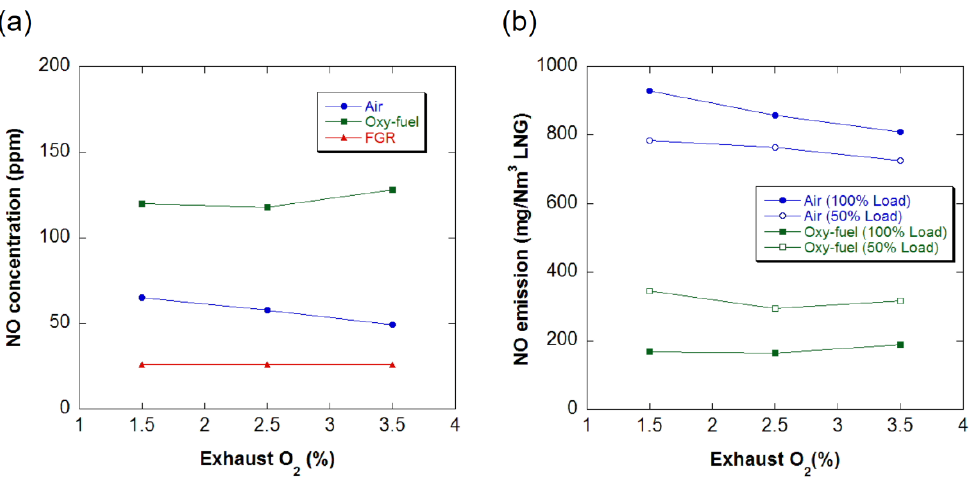
Figure 13. NO emission. ( a ) NO concentration at 100% load and ( b ) NO emission per unit fuel consumption.